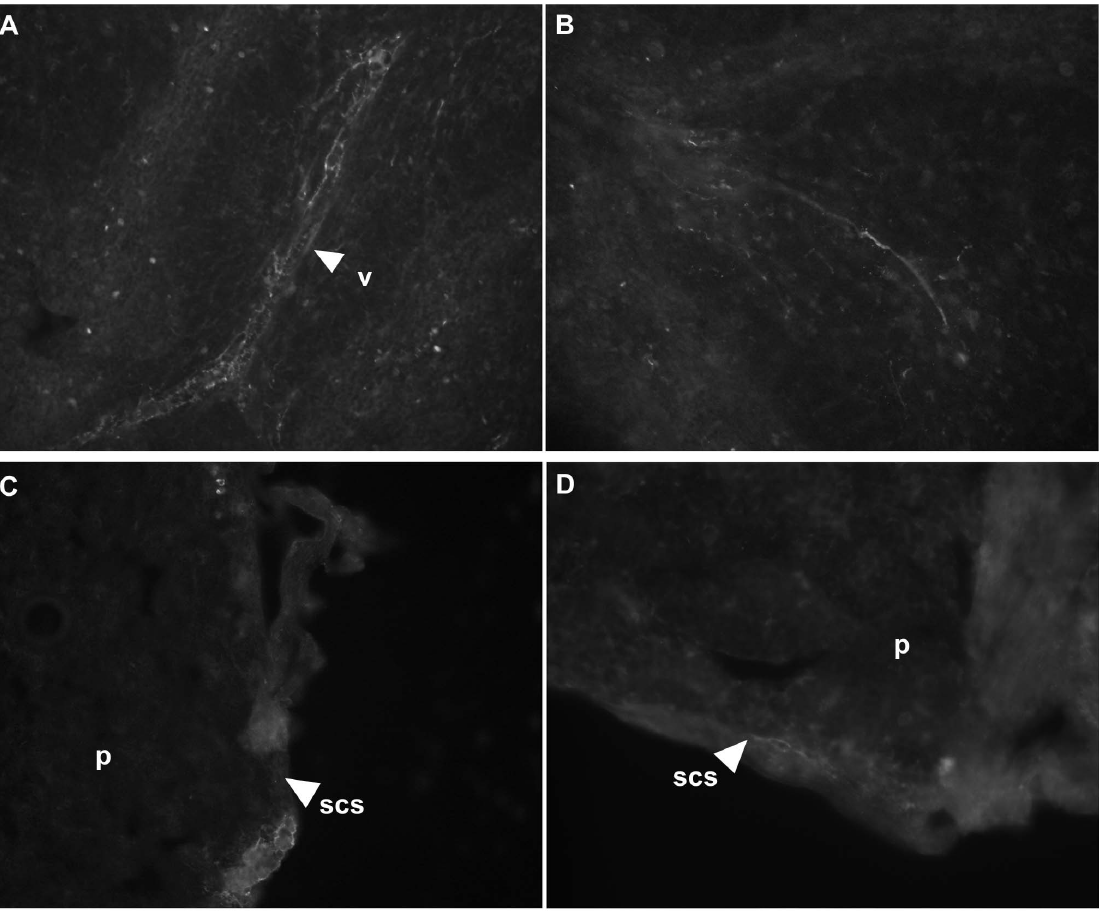
Figure 5. Spleen and LN are innervated at physically relevant locations. Fixed, frozen sections of spleen (A and B) and pancreatic LN (C and D) from C57BL/6 mice were stained with anti-NSE antibody and visualized with Cy3-conjugated secondary antibody. (A) and (B), 200 6 magnification; (C) and (D), 400 6 magnification. Figure labels: v, vascular plexus; scs, subcapsular sinus; p, parenchyma.